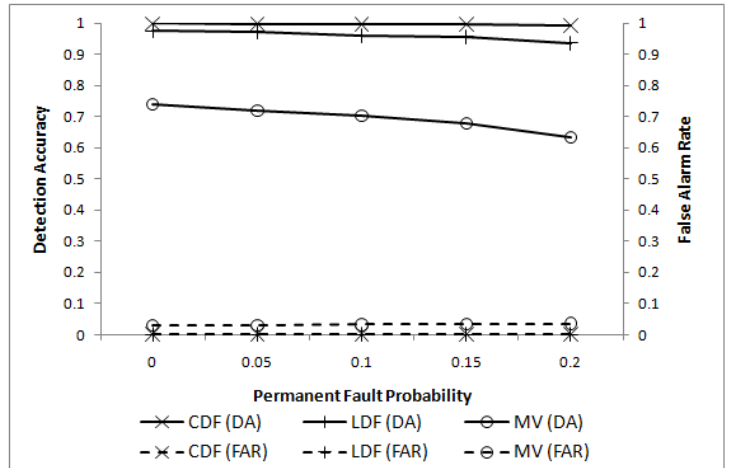
Figure 4. Comparison of CDF and